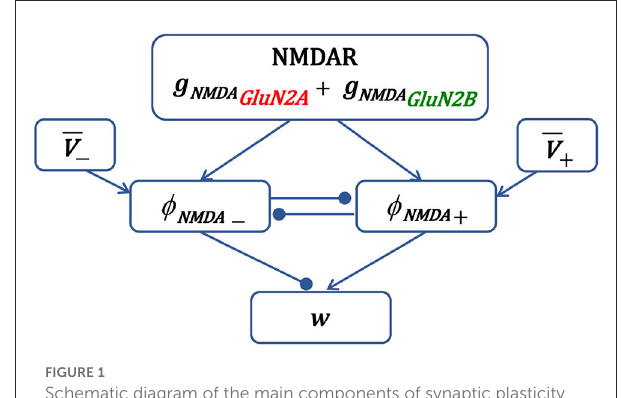
FIGURE1 Schematic diagram of the main components of synaptic plasticity model. Presynaptic action potential activates NMDAR, induces the NMDAR conductance, composed of GluN2A-NMDAR and GluN2B-NMDAR subunits g NMDA and g NMDA , and triggers GluN 2 A GluN 2 B variables φ NMDA + and φ NMDA − that account for the LTP and LTD contribution, respectively. The LTP variable φ NMDA + , once activated, inhibits the LTD variable φ NMDA − to prevent LTD, and vice versa. Postsynaptic local membrane potential V is low-pass filtered, and the resulting LTP and LTD variables V + and V − are multiplied by the corresponding NMDAR-dependent variables φ NMDA + and φ NMDA − to form the LTP and LTD components of the weight w